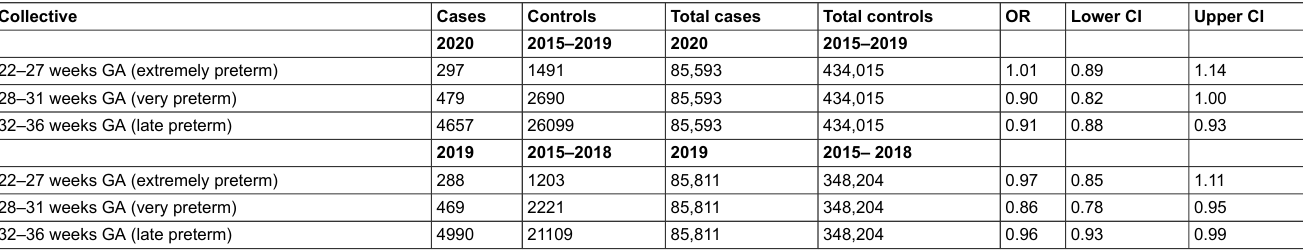
Table 1: Number of births per gestational age range, odds ratios for preterm birth based on FSO data.